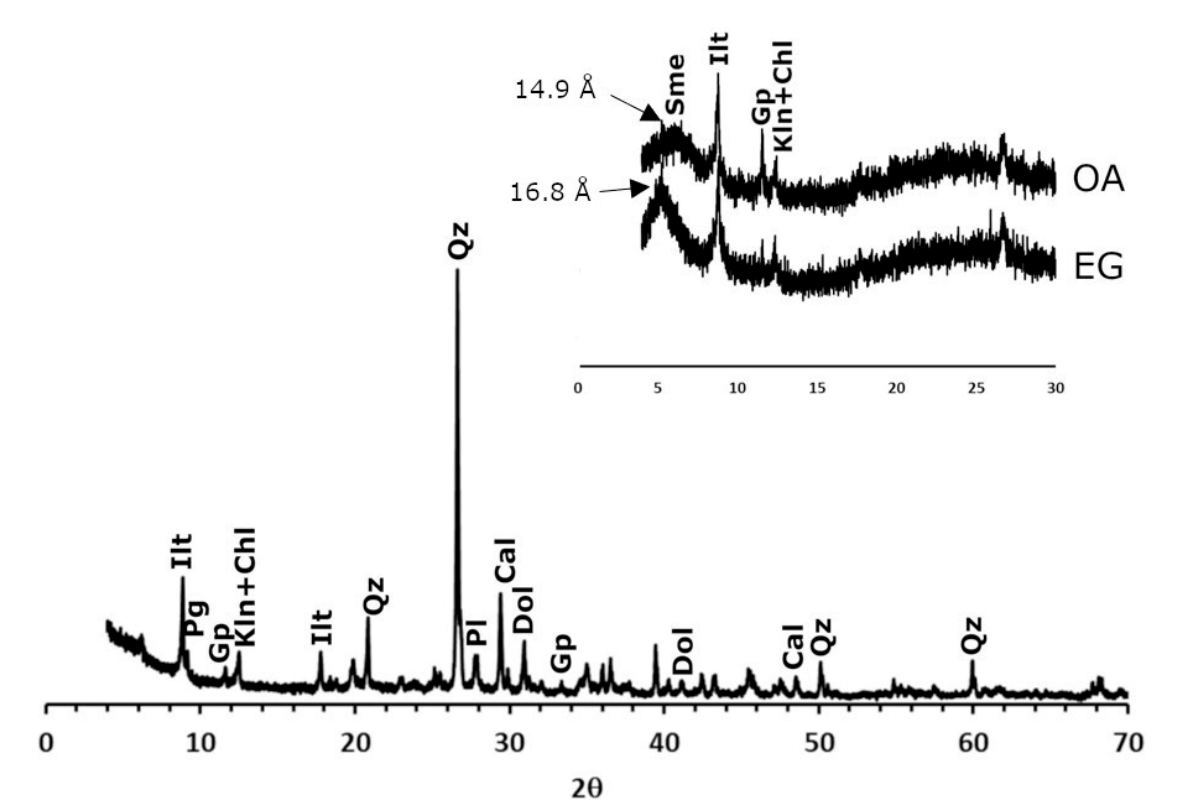
Figure 2. X-ray diffraction patterns of the clayey earth from Viznar. Ilt: illite; pg: paragonite; chl: chlorite; kln: kaolinite; qz: quartz; pl: plagioclase; cal: calcite; dol: dolomite; gp: gypsum; sme: smectites. Abbreviations suggested by Warr [40]. In the inset: an oriented aggregate sample of the clay fraction without treatment (OA) and after treatment with ethylene glycol (EG).